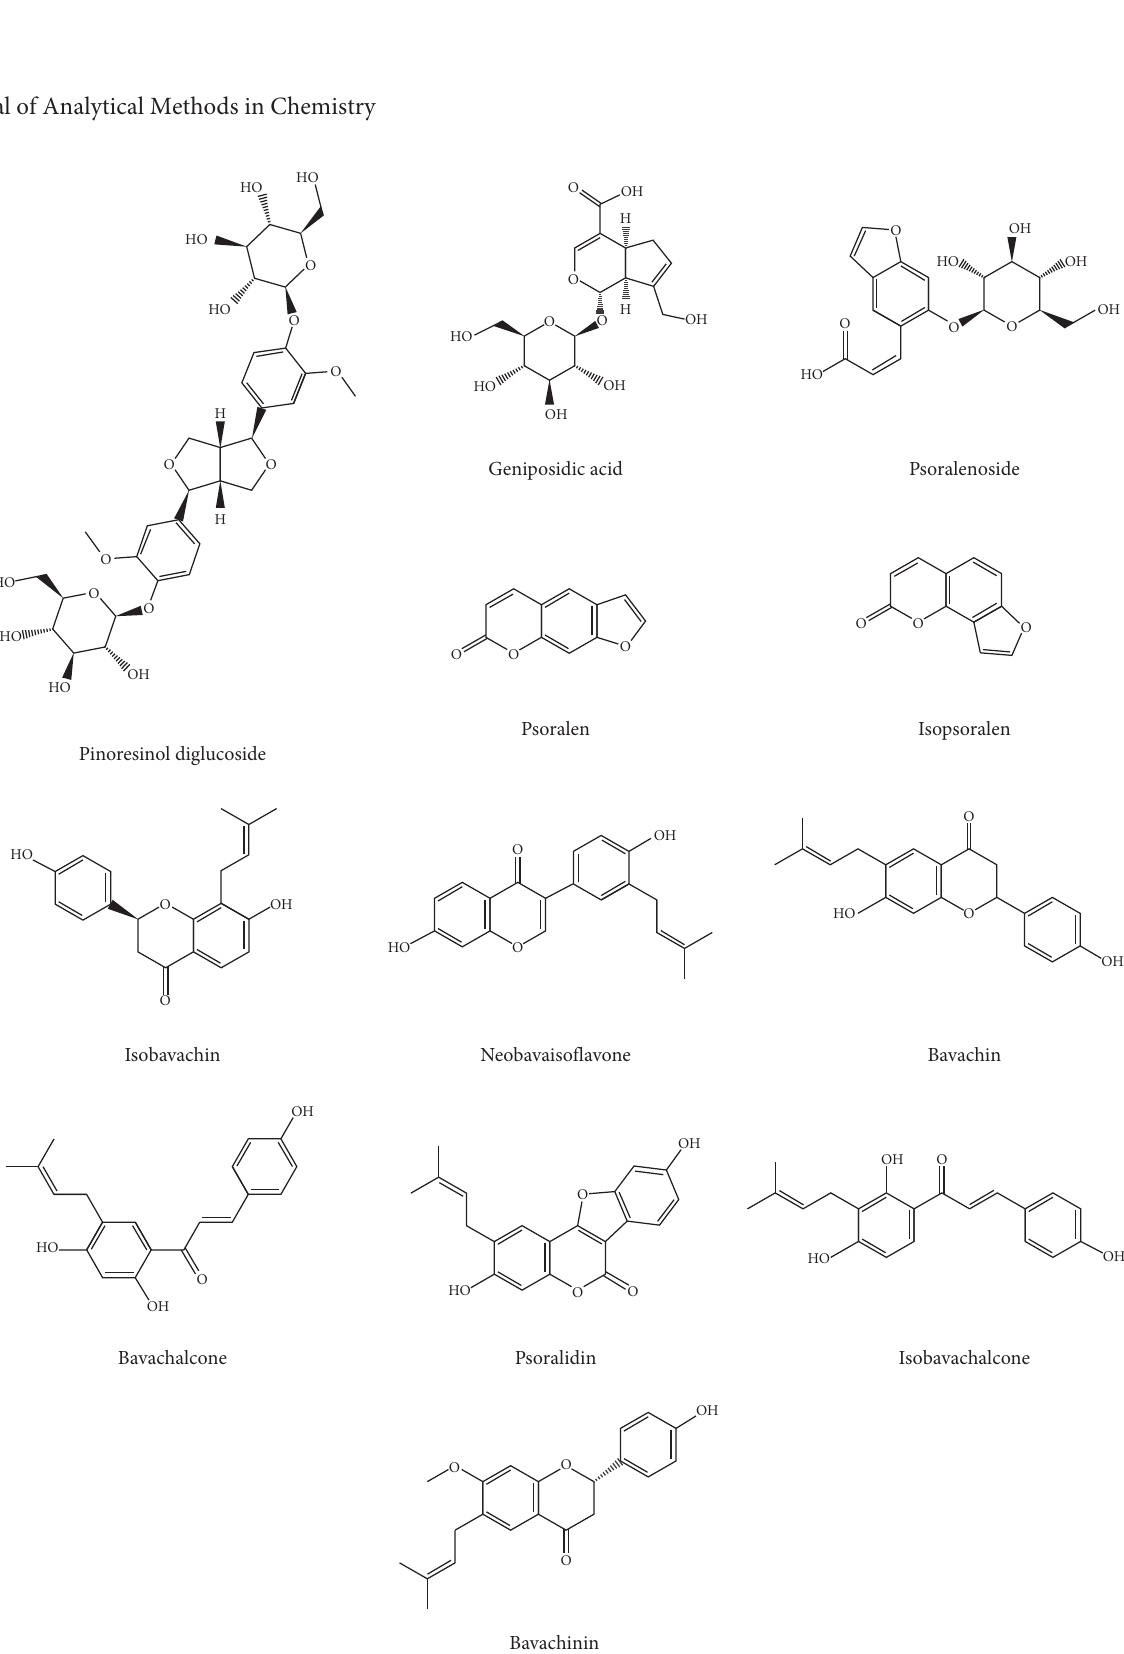
Figure 1: Chemical structures of 12 standard